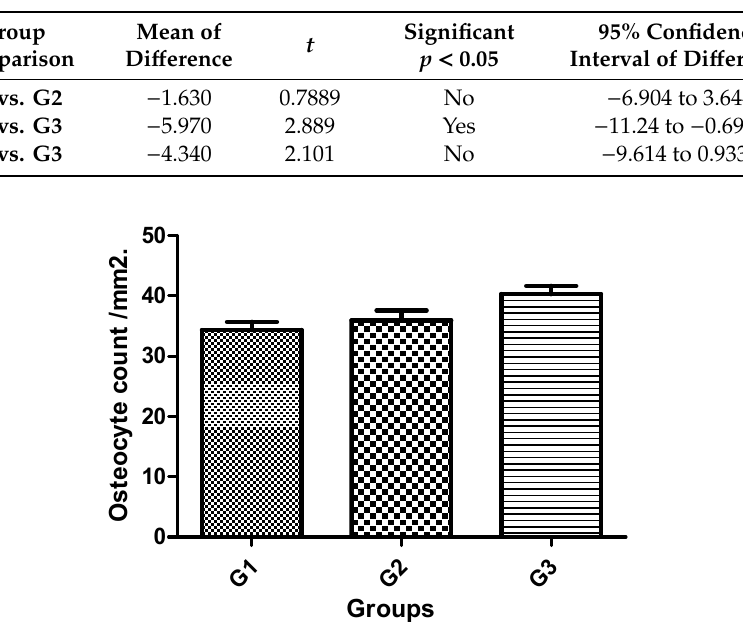
Figure 11. Bar graph of the osteocyte count per mm 2 mean and standard deviation.